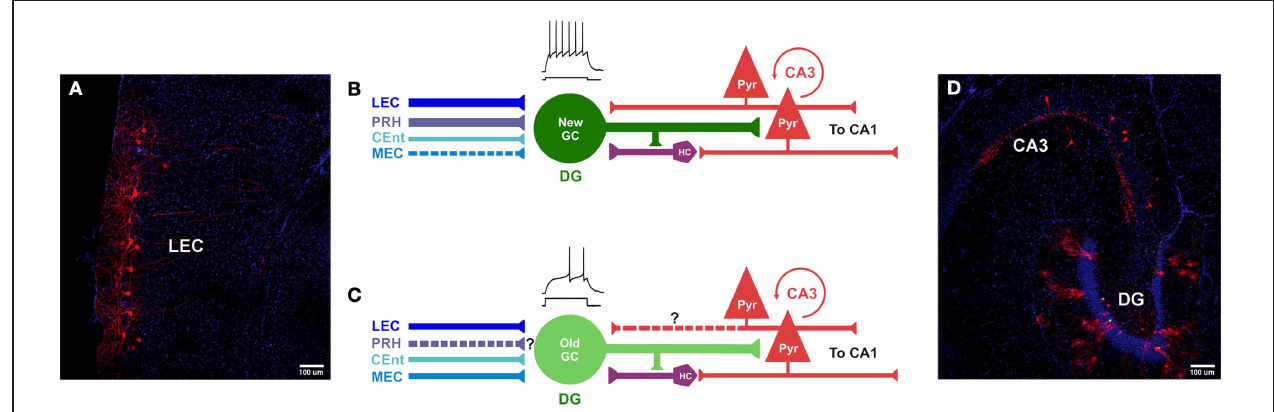
FIGURE 5 | Comparison of inputs to newborn and mature GCs. (A–D) Photomicrographs and models of inputs, and their hypothesized relative synaptic strengths, onto newborn and mature GCs. (A,D) Photomicrographs of horizontal sections (40 µ m) derived from a mouse injected with retrovirus, followed by rabies virus at 30dpi (30dpi retrovirus + 7dpi rabies virus). (A) Retrograde tracing is observed in cortical layers II/III of LEC, traced cells express MCherry (red) and nuclei are labeled with DAPI (blue). (B) Newborn GCs receive synaptic input from PRH, LEC and CEnt rather than from MEC. The new neurons are highly excitable, their mossy fiber outputs enable firing in area CA3 pyramidal cells. New GCs receive both direct and indirect “back-projections” from